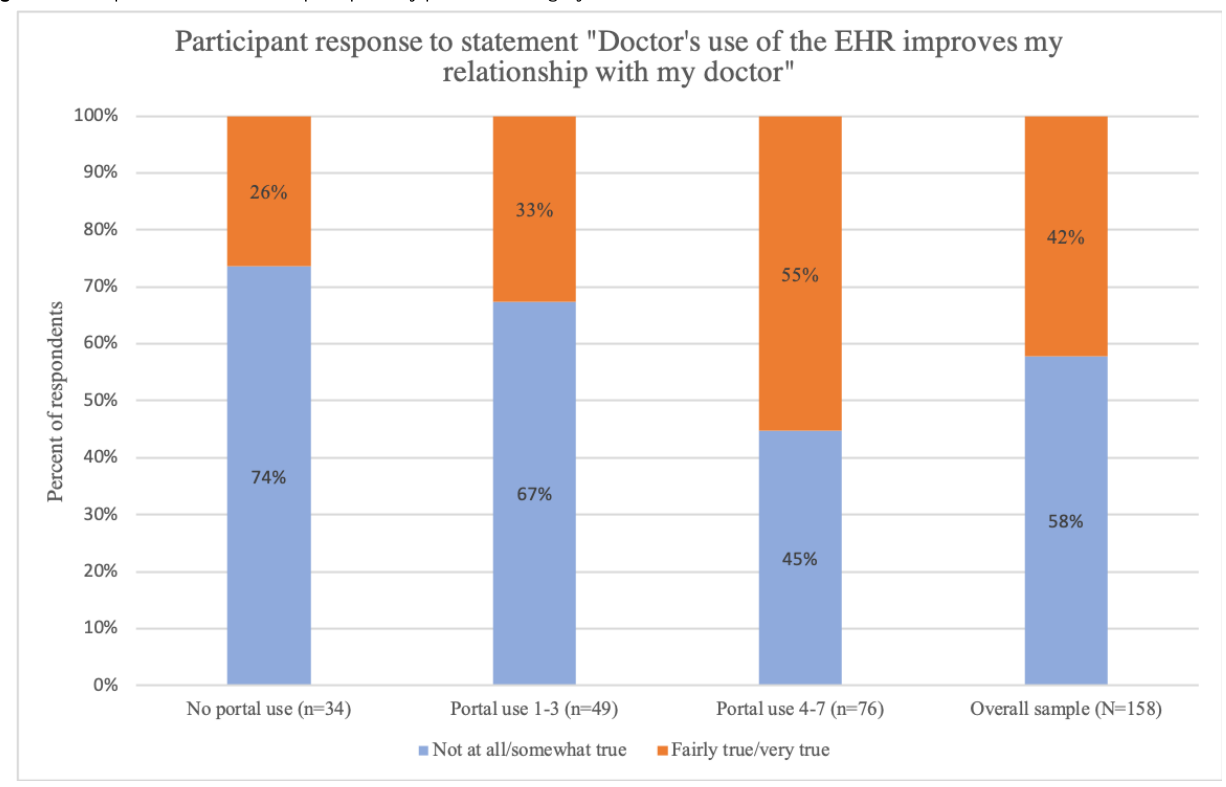
Figure 3. Comparison of EHR value perception by portal use category. EHR: electronic health